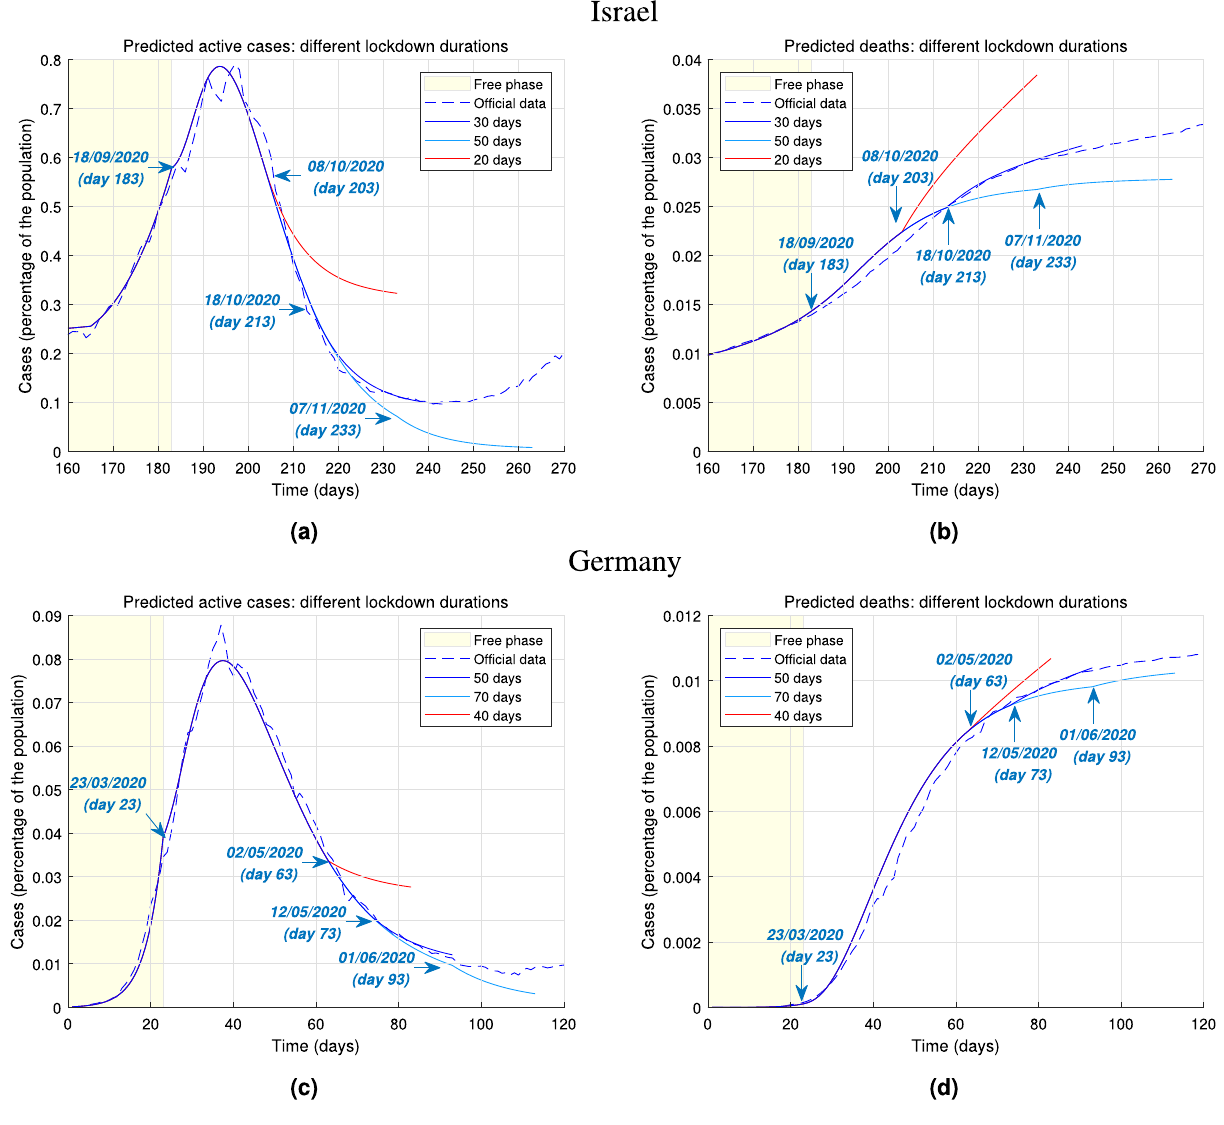
Figure 3. Predicted epidemic evolution under different lockdown durations. Evolution of the COVID-19 epidemic in Israel and Germany as predicted by our model, based on available government data. ( a ) Actual evolution and model predictions of the active cases of infections in Israel by lockdown duration. ( b ) Actual evolution and model predictions of the deaths in Israel by lockdown duration. ( c ) Actual evolution and model predictions of the active cases of infections in Germany by lockdown duration. ( d ) Actual evolution and model predictions of the deaths in Germany by lockdown